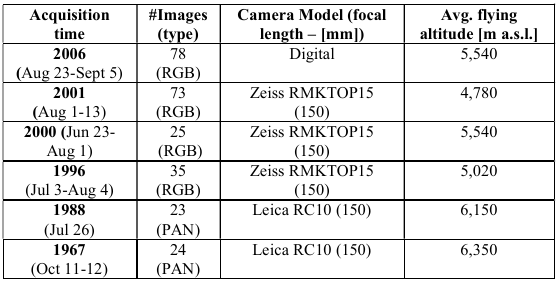
Table 1. Properties of photogrammetric datasets from IGNF online repository (PAN : panchromatic; RGB : colour images).